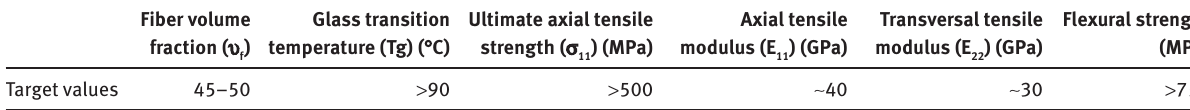
Table 4: Target values for material